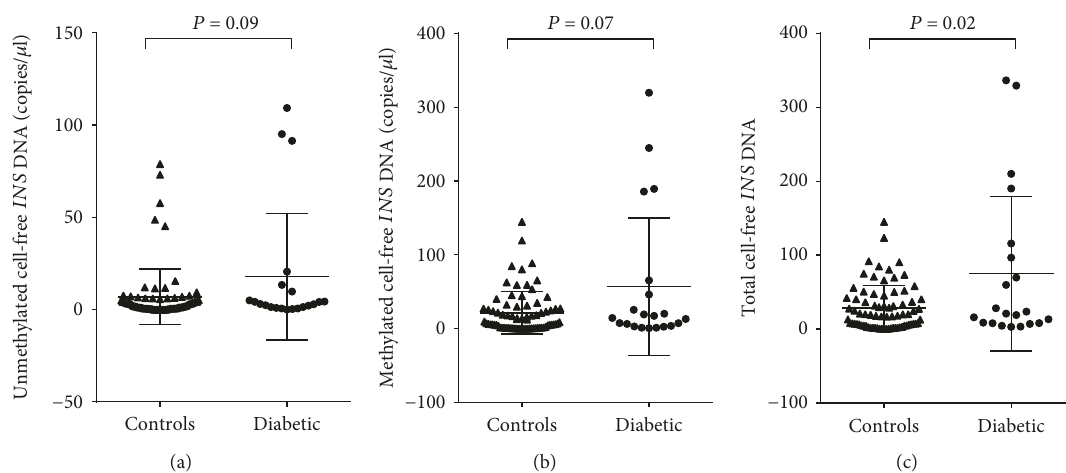
Figure 1: Postpartum circulating cell-free INS DNA levels in women with a previous GDM pregnancy. Droplet digital PCR was used to measure levels of cell-free circulating methylated (a) and unmethylated (b) INS DNA in plasma from 97 women, 12 weeks following an index GDM pregnancy. After 10 years, 76 women remained NGT (controls; NGT) while 21 women developed T2DM (T2DM). (c) Cell-free total INS DNA levels represent the sum of the unmethylated and methylated INS DNA levels. Data are presented as mean ± sd